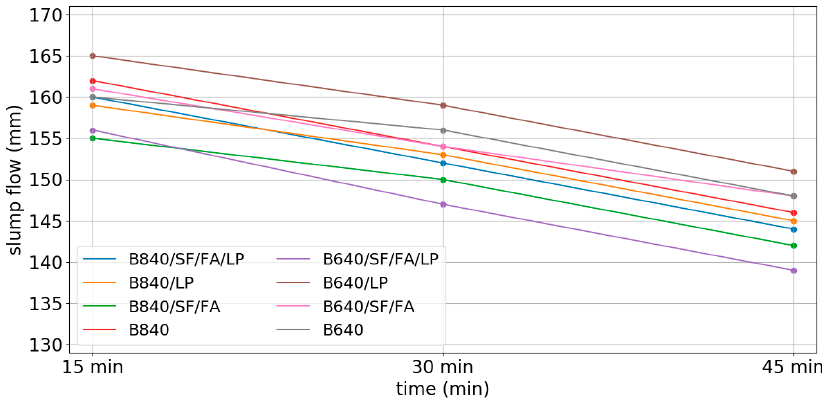
Figure 5. Slump flow test results.